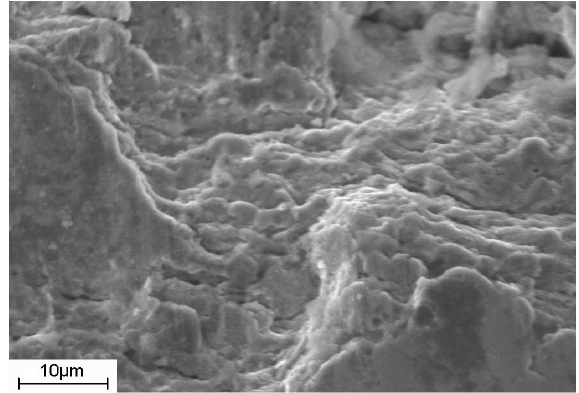
Figura 8: Rottura a fatica di zone perlitiche in un acciaio UNI 34CrMo4 legato con B, temprato e rinvenuto. Regione a cuore di una barra di diametro 90 mm. Microstruttura prevalente a cuore ferritico-perlitica [6]. Figura 8: Fatigue rupture of pearlitic areas at core of a quenched and tempered, B alloyed, 34CrMo4 steel bar, with a 90 mm dia. bar. Ferritic- pearlitic microsructure prevailing at core